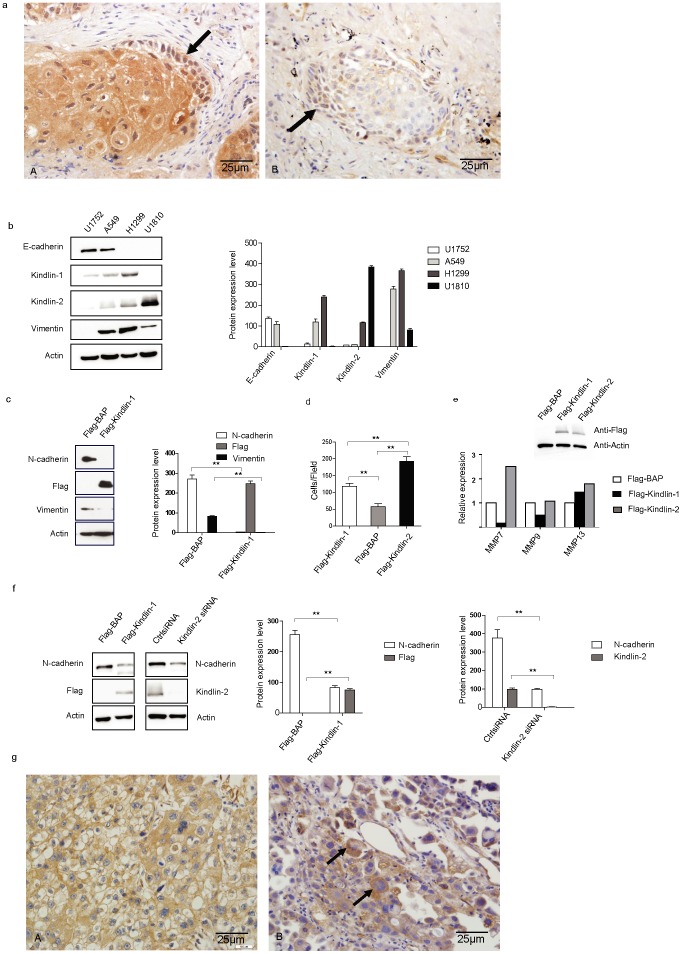
Kindlin-1 and Kindlin-2 oppositely regulate lung cancer cell migration and invasion.a. Expression of Kindlin-1 and Kindlin-2 in the secondary de novo SCC from an invasive SCC patient. A. Kindlin-1 expression in the de novo SCC. B. Kindlin-2 expression in the de novo SCC from the same patient as in A. b. Left panel: Differential expression of Kindlin-1, Kindlin-2, E-cadherin and Vimentin in various lung cancer cell lines controlled by actin for loading. Right panel: Quantification of the relative protein expression levels. c. Left panel: Stable expression of Kindlin-1 in H1299 cells. Indicated are mixed stable clones that express Flag-Kindlin-1. Right panel: Quantification of the relative protein levels for Kindlin-1 regulated N-cadherin and Vimentin. d. Kindlin-1 and Kindlin-2 differentially regulate migration in H1299 cells. Displayed is the quantification and plot as mean ± SEM from three independent experiments. Statistical analyses between different cell groups were examined by Student's t test. ** represents for p<0.01. e. Kindlin-1 and Kindlin-2 differentially regulate the mRNA levels of MMPs analyzed by qPCR in H1299 cells stably expressing Kindlin-1 and Kindlin-2. Insert shows expression of Kindlin-1 and Kindlin-2 in the stable mixed clones applied in qPCR. f. Left panels: Expression of Kindlin-1 downregulates N-cadherin and Knockdown of Kindlin-2 downregulates N-cadherin. Right panels: Quantification of the relative protein levels for Kindlin-1- and Kindlin-2-regulated N-cadherin. Statistical analyses between different cell groups were examined by Student's t test. ** represents for p<0.01. g. Expression of Kindlin-2 in lymph node metastasized large cell lung cancer patient. A. Primary large cell lung cancer; B. Lymph node metastasized large cell lung cancer from the same patient.